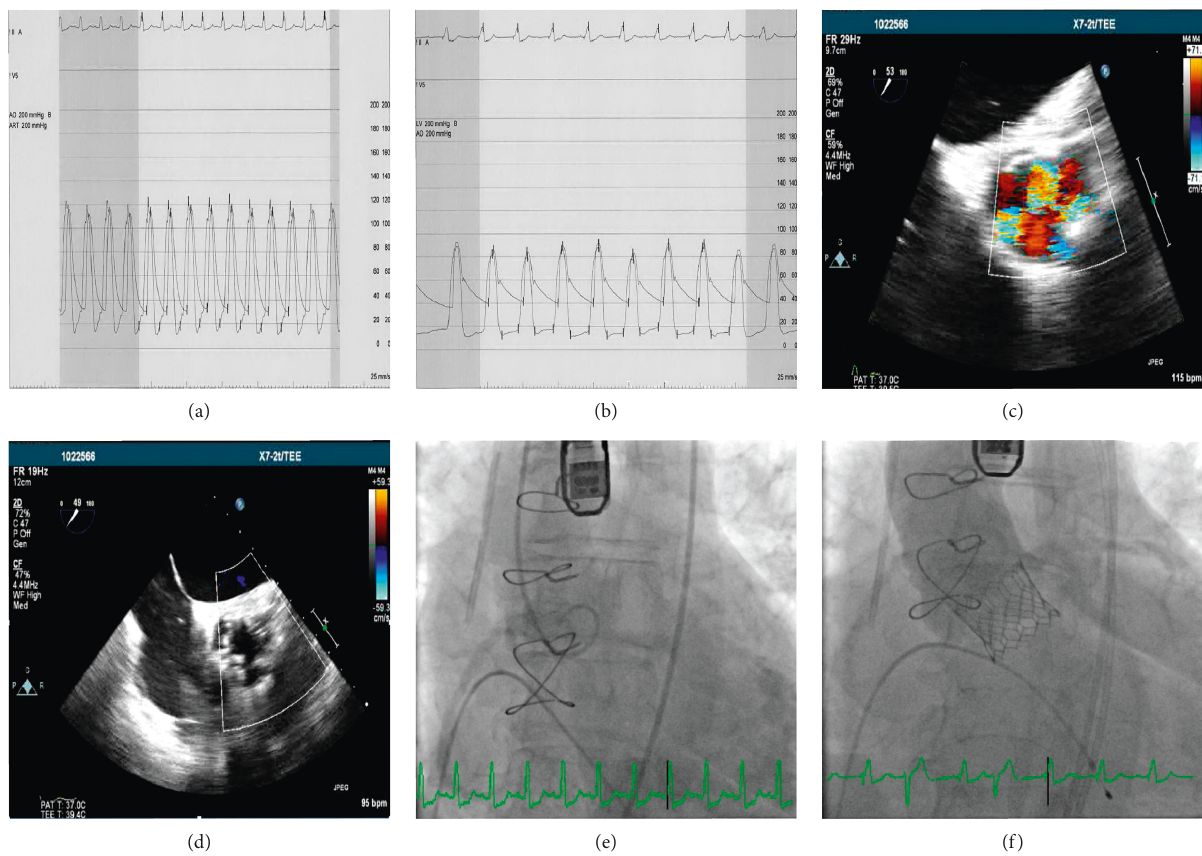
Figure 2: (a) Pre-TAVI simultaneous aortic and left ventricular pressures demonstrating equalization of Ao diastolic LV end-diastolic pressures. (b) Post-TAVI hemodynamics revealing normal diastolic LV-Ao gradient and no systolic LV-Ao gradient. (c) Pre-TEE image of the bioprosthetic aortic valve during diastole shows three large regurgitant jets. (d) Post-TEE short axis of the TAVI valve during diastole shows absence of regurgitant flow. (e) Pre-TAVI aortogram shows 4+ aortic insufficiency. (f) Post-TAVI aortogram shows no aortic insufficiency and acceptable implantation depth. TAVI � transcatheter aortic valve replacement; Ao � aortic; LV � left ventricular; TEE � transesophageal